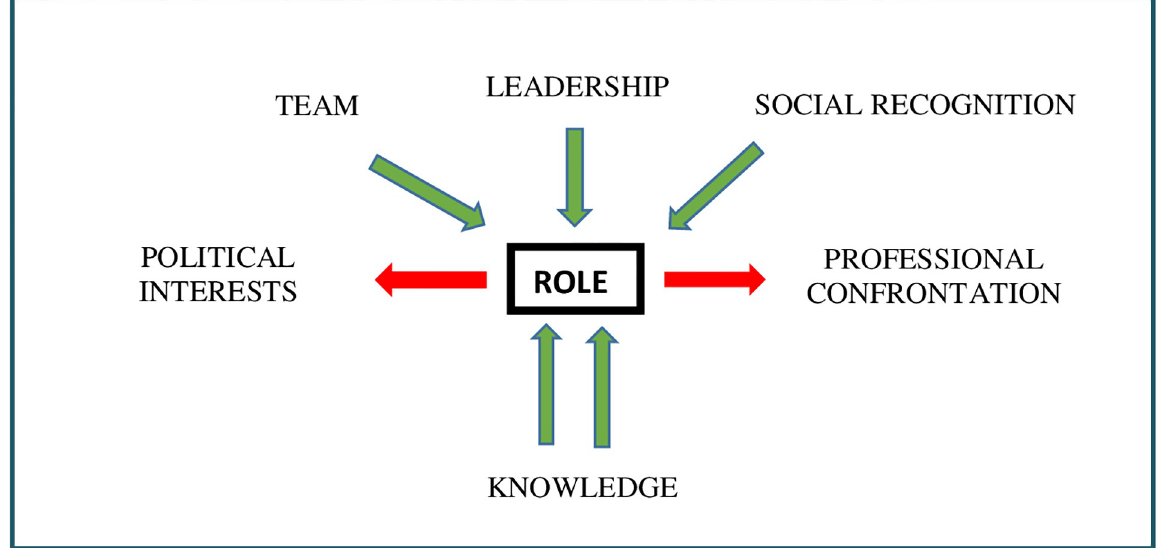
Fig 1. Elements that shape the